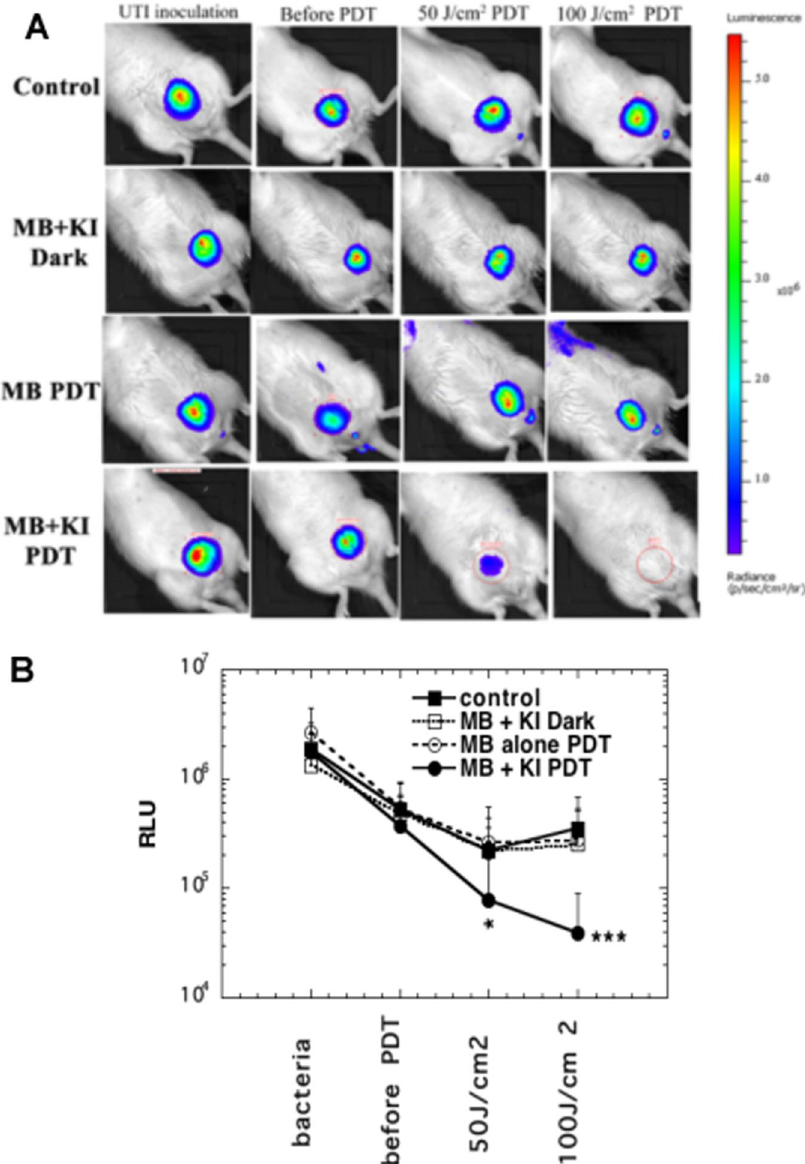
Figure 3. Effectiveness of aPDT on day 0. ( A ) Panel of representative bioluminescent images showing aPDT dose response on the same day of treatment. ( B ) Plot of mean bioluminescence values showing aPDT dose response. Values are means and SD of bioluminescence RLUs from n = 5–9 rats per group. * p < 0.05; *** p <